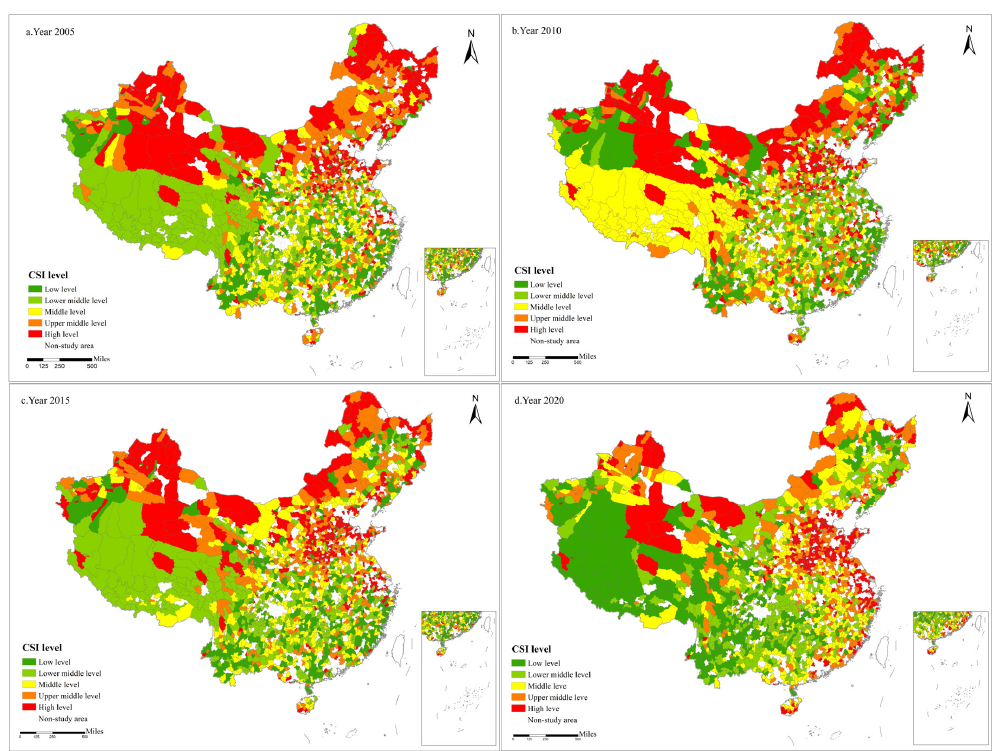
Figure 2. Spatial distribution pattern of county sprawl.